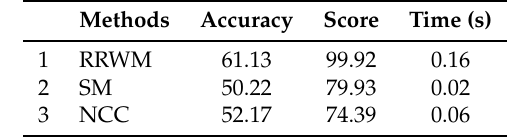
Table 6. Comparative evaluation on CALTECH database for RRWM, SM, and NCC.